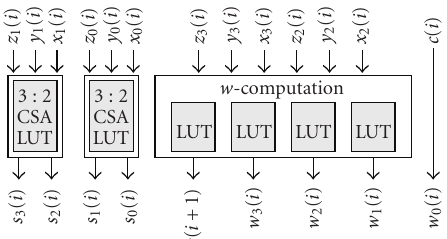
Figure 7: (3 : 2) CSA type2 implementation.